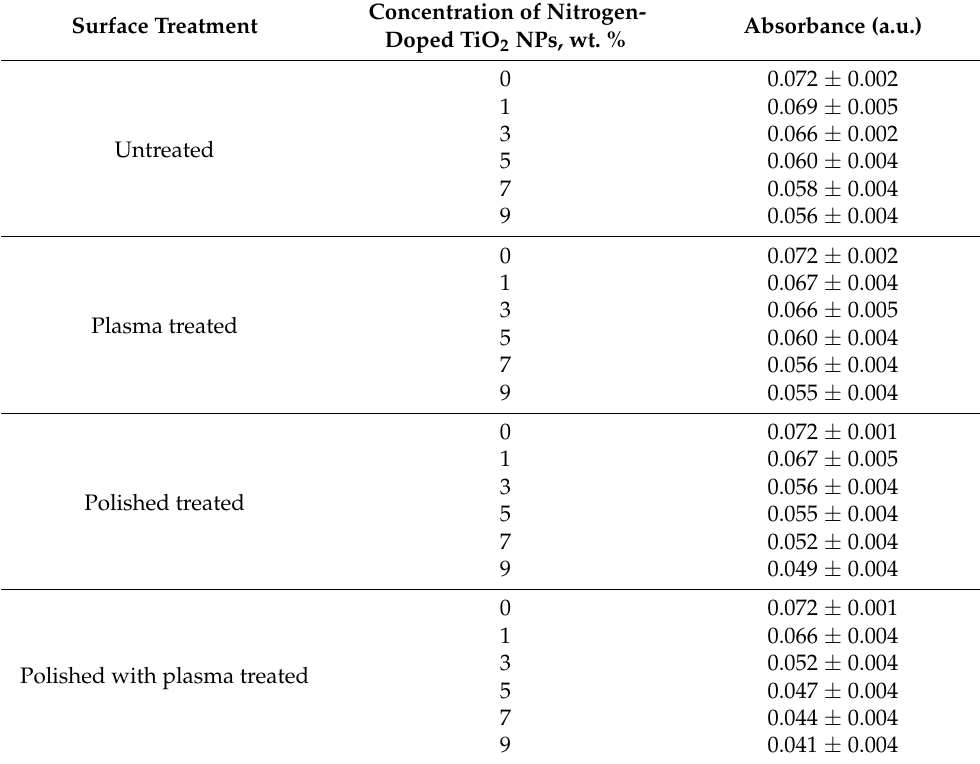
Table 7. The mean absorbance observed for resin disk samples with different wt. % powder concen- trations (0–9 wt. %), exposed to different surface treatments (unpolished, plasma treated, polished, and polished with plasma treatment) under light conditions. Concentration of Nitrogen- Surface Treatment Absorbance Doped TiO 2 NPs, wt. %